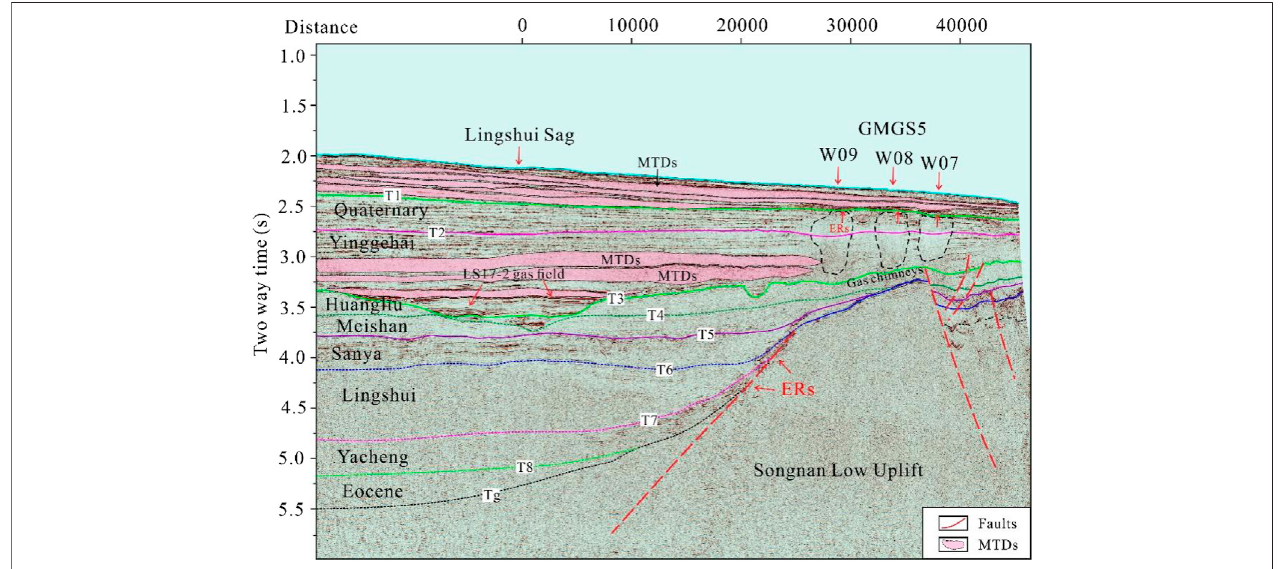
FIGURE6 | Seismic re fl ection features ofthebottom simulating re fl ector(BSR),diapirs,gas chimneys, and faults in the QDNB, showing the accumulationprocess of the hydrate-related gas at the site GMGS5-W08.